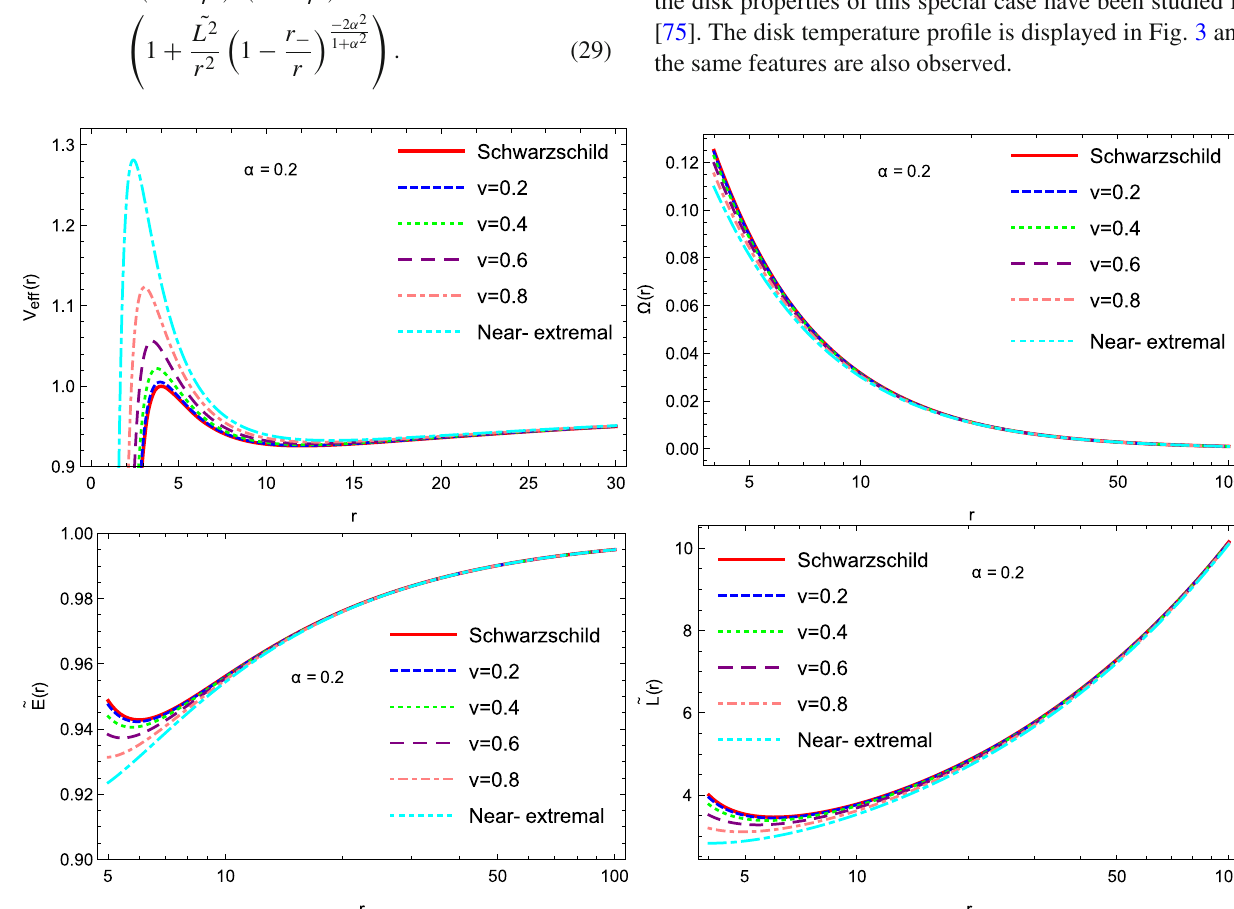
Fig. 1 The effective potential V ef f ( r ) . Top-left panel: the angular velocity (cid:8)( r ) . Top-right panel: the specific energy ˜ E ( r ) . Bottom-left panel:thespecificangularmomentum ˜ L ( r ) .Bottom-rightpanel:astatic charged dilaton black hole with total mass M = 2 . 5 × 10 6 M (cid:10) shown